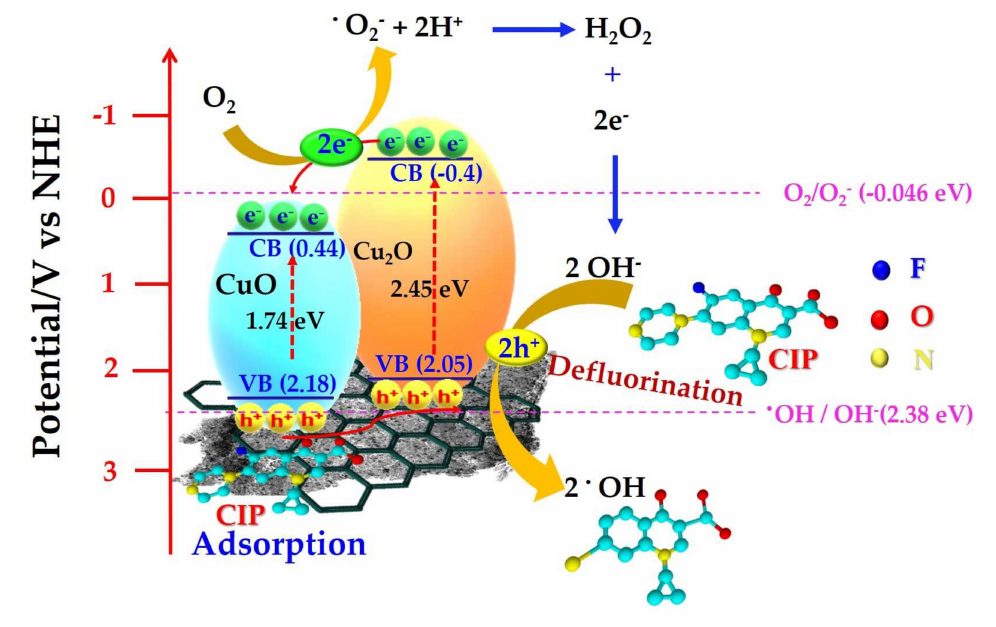
Figure 7. The proposed mechanism for the enhanced CIP photocatalytic activity using mixed phase Cu x O/MOF under visible light